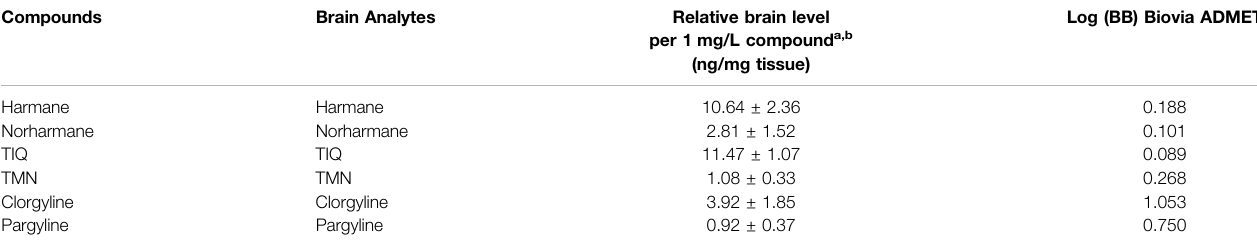
TABLE 2 | Summary of compound bioavailability in fi sh brain. Compounds Brain Analytes Relative brain level